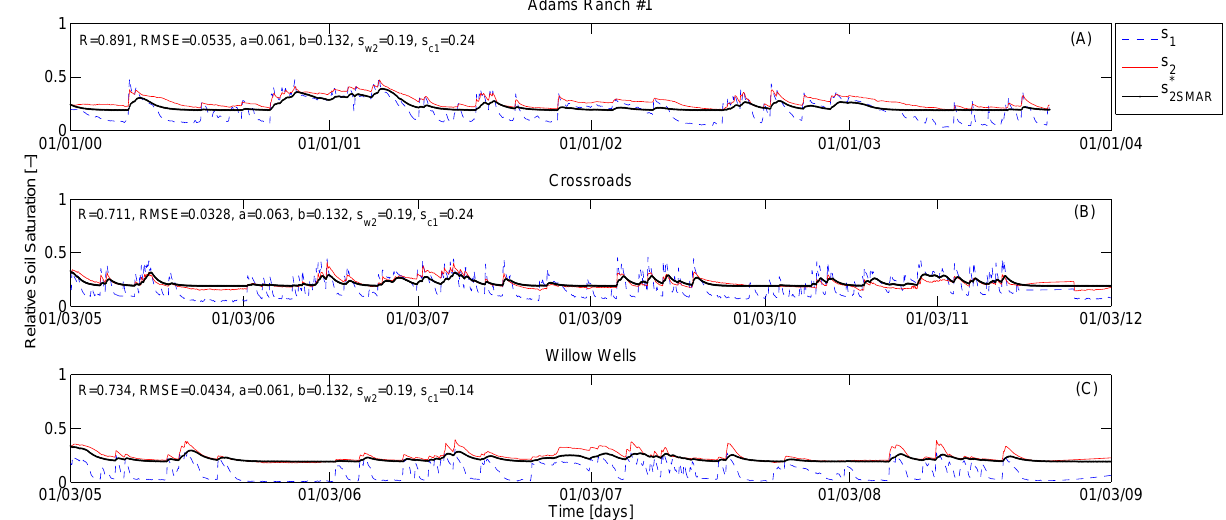
Fig. 8. Comparison between the relative saturation of the surface soil layer ( s 1 ) and the averaged value over 90cm depth ( s 2 ), and the filtered value ( s ∗ – black line) obtained with SMAR for three sites located at Adams Ranch #1 (A) , Crossroads (B) , and Willow Wells (C) , 2SMAR respectively. Results have been obtained assigning parameters based on the physical characteristics of the study